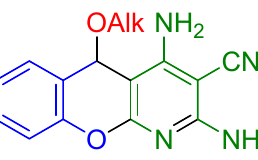
Figure 2. 5-Alkoxy-5 H -chromeno[2,3- b ]pyridine 4 .